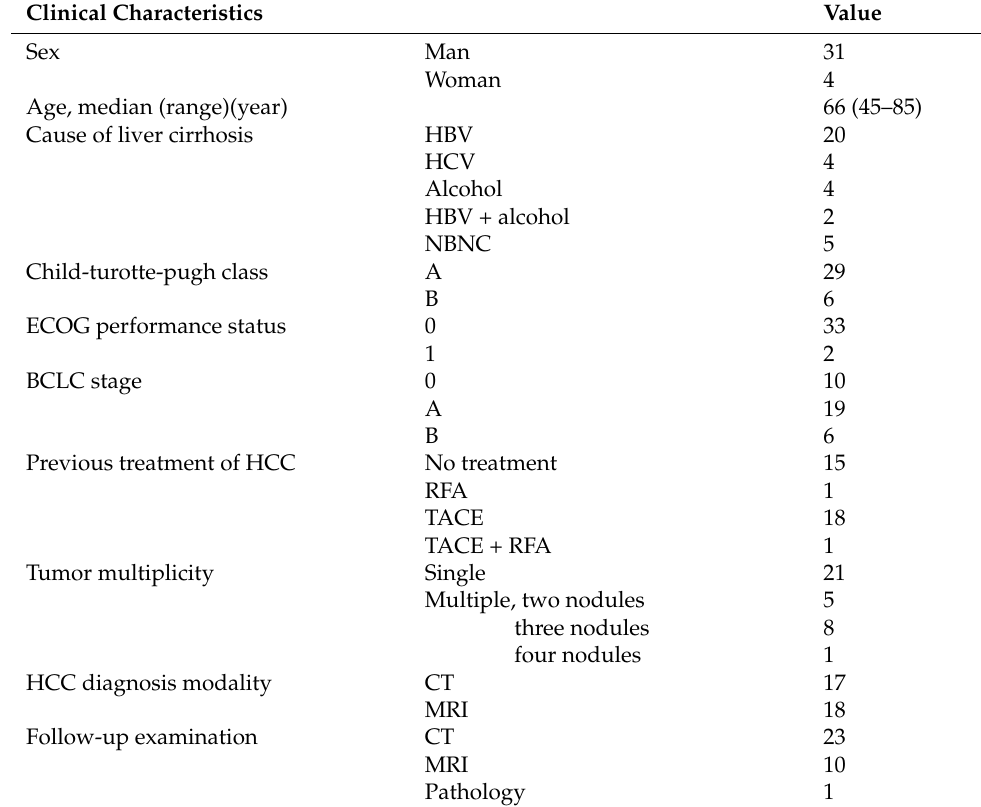
Table 1. Baseline demographics and clinical characteristics of patients. Clinical